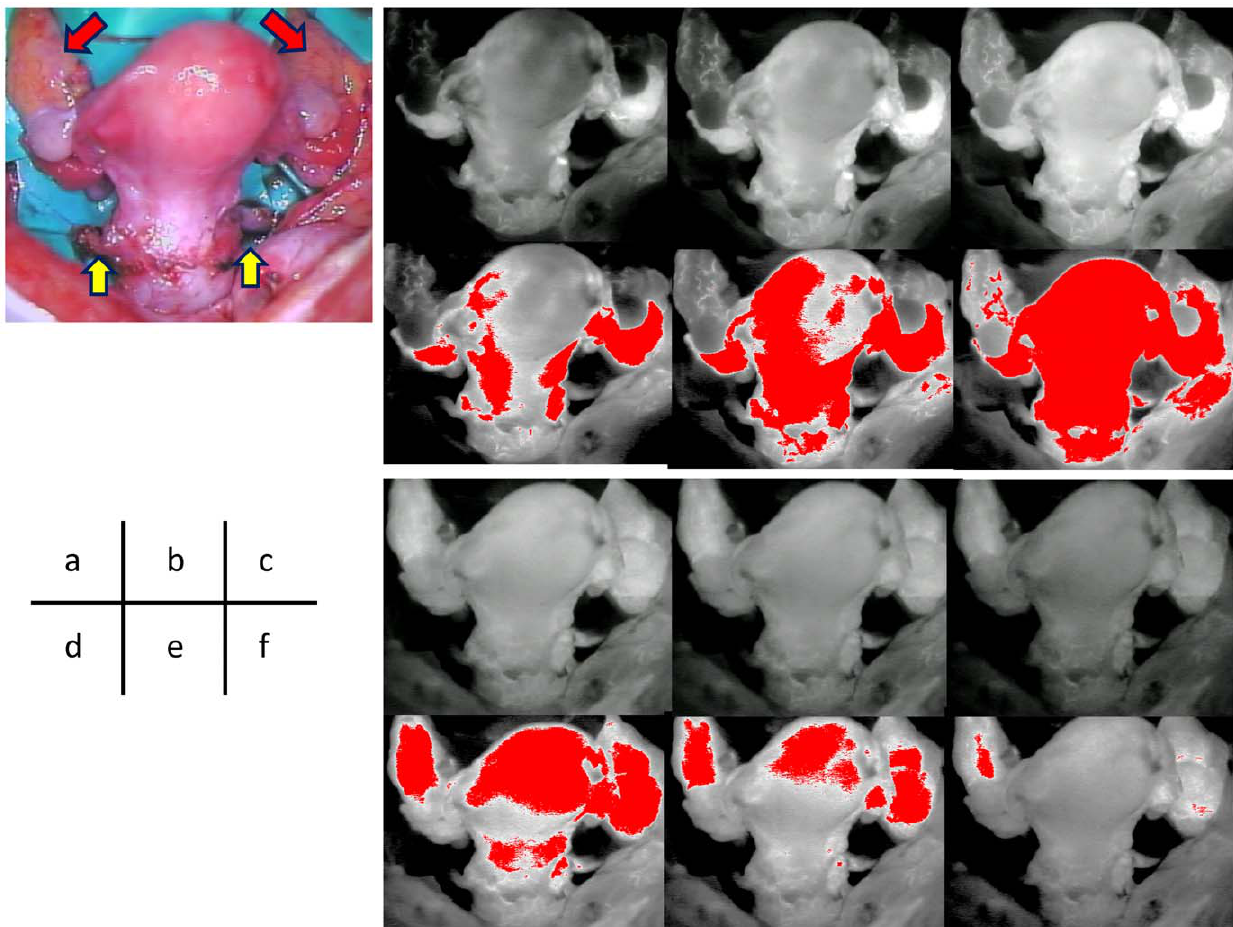
Figure 3. Temporal distribution of uterine blood flow observed by ICG fluorescence imaging after (a) 5 s, (b) 8 s, (c) 12 s, (d) 35 s, (e) 45 s, and (f) 60 s. Upper: ICG fluorescence imaging; lower: Regions with fluorescence intensity $ 100 are shown in red. Uterine artery/vein (yellow arrow) and ovarian artery/vein (red arrow).